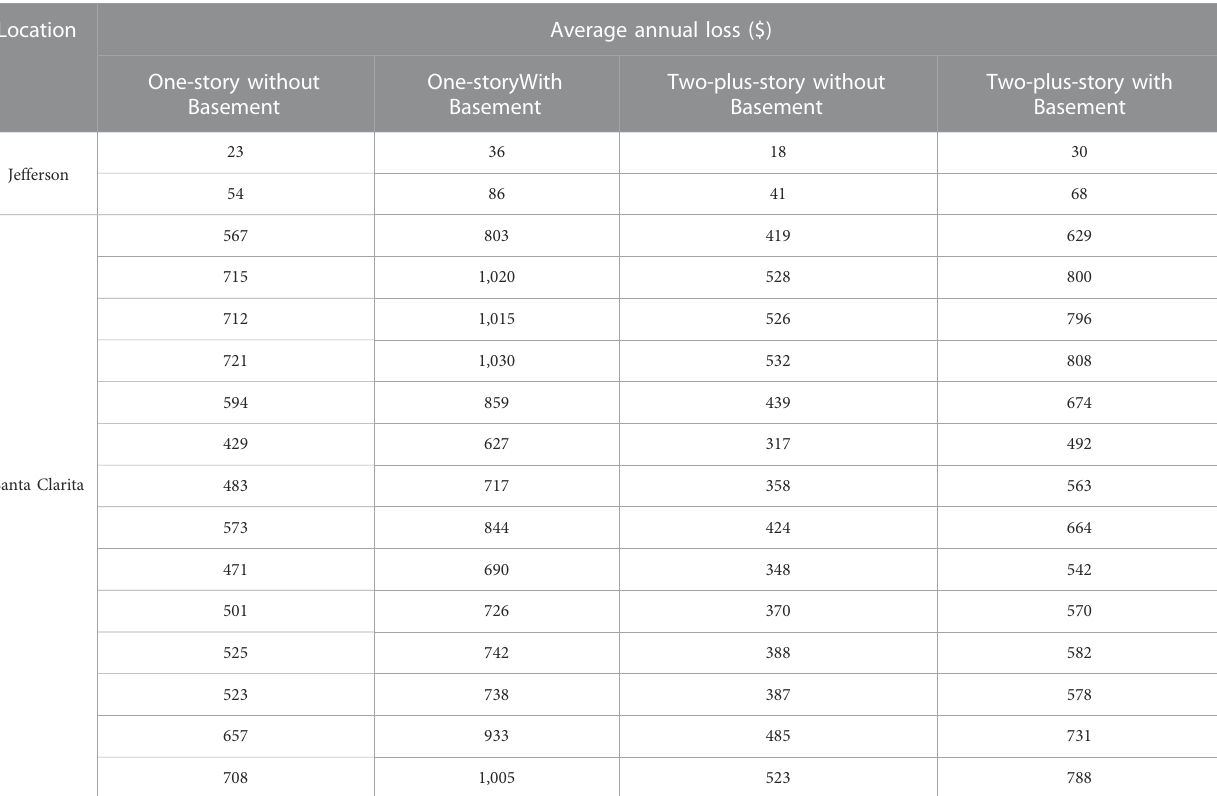
TABLE 10 Average annual loss (i.e., annual fl ood risk) by type of single-family home in Jefferson Parish, Louisiana, and Santa Clarita, California, implementing spatial interpolation parameters. Location